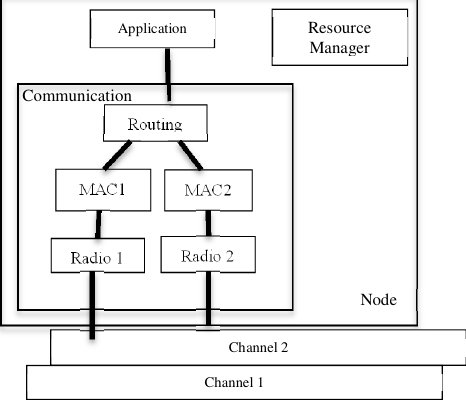
Figure 3: Dual-channel Castalia node